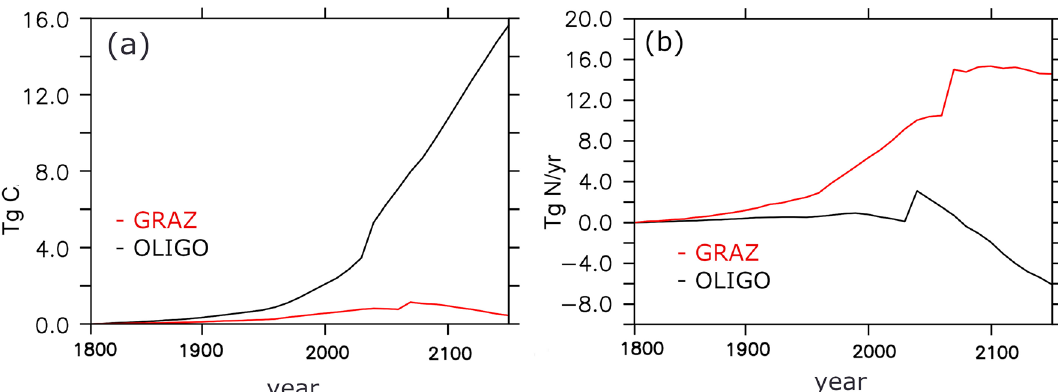
Figure 3. Projected evolutions along an RCP 8.5 63 emission trajectory referenced to 1800 as simulated with configurations GRAZ (red lines) and OLIGO (black lines). ( a ) refers to global annual mean diazotrophic biomass in units Tg C. ( b ) refers to global annual mean nitrogen fixation in units Tg N yr − 1